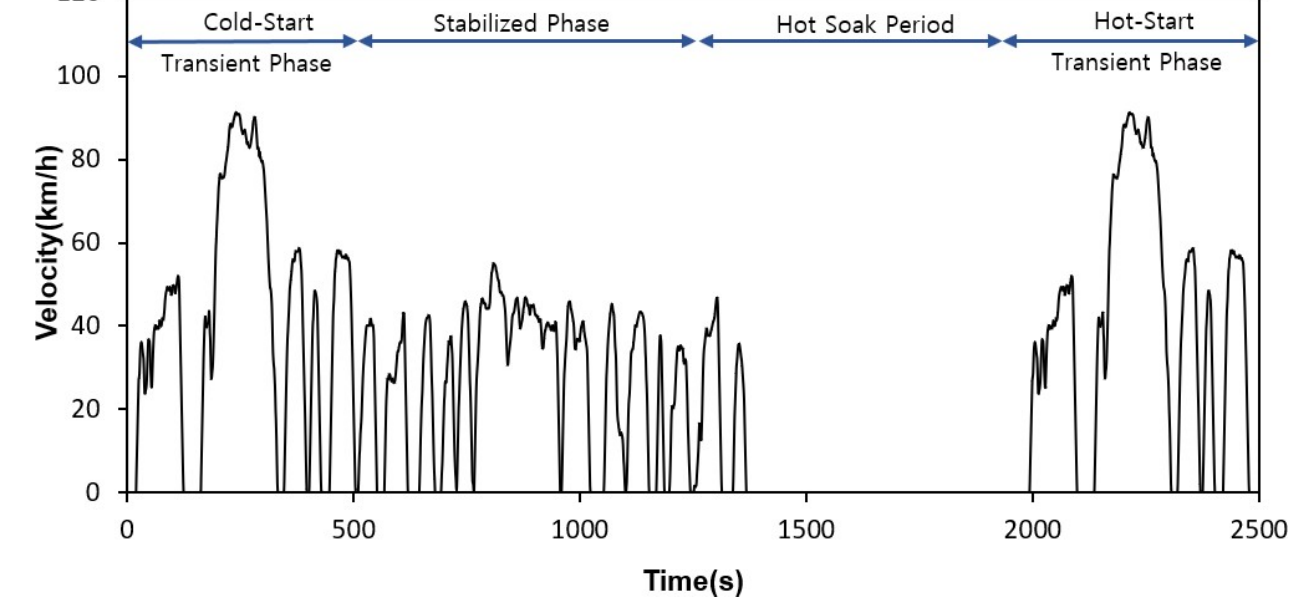
Figure 9. FTP-75 driving cycle.